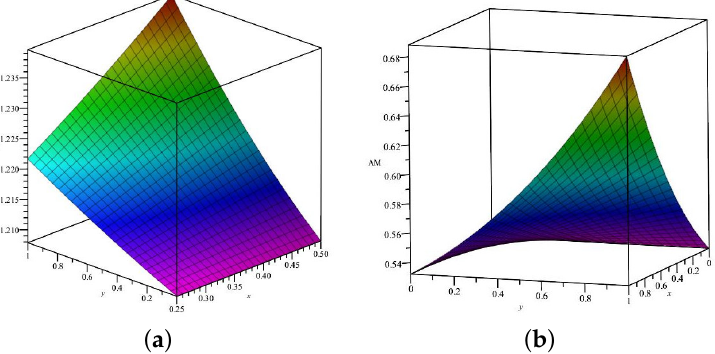
Figure 1. Graphs related to the aggregation functions AM and GM for di ff erent values. ( a ) ω 1 ∈ ∈ [ 0,1 ] ; ( b ) ω [ 1 ] , ω , 1 2 2 4